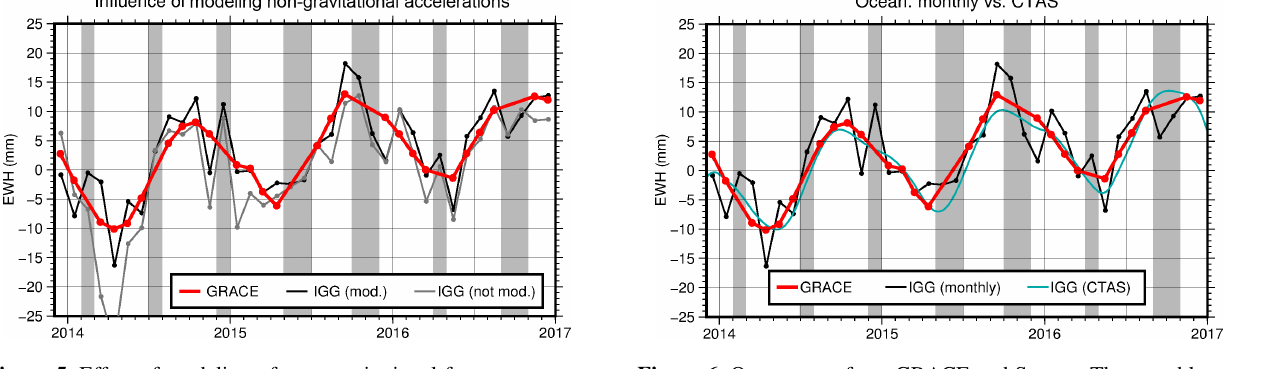
Figure 6. Ocean mass from GRACE and Swarm. The monthly so- lution is shown in black while the CTAS solution is shown in blue. The parameterizations for the two solutions can be found in Table